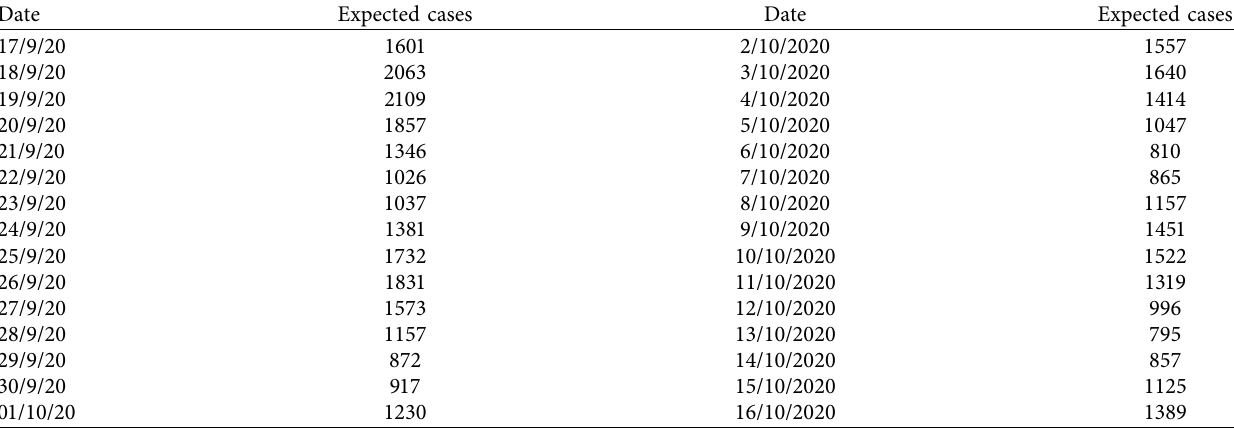
Table 8: The prediction epidemic results of the new COVID-19 in Southern Africa for the next month as predicted by the ARIMA (4,1,5) model.